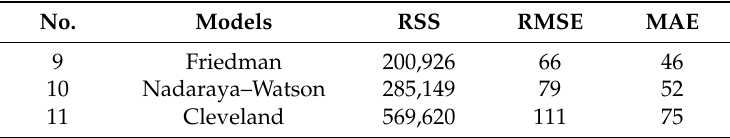
Figure 7. Curve fitting by nonparametric models. Table 3. Results for nonparametric models.